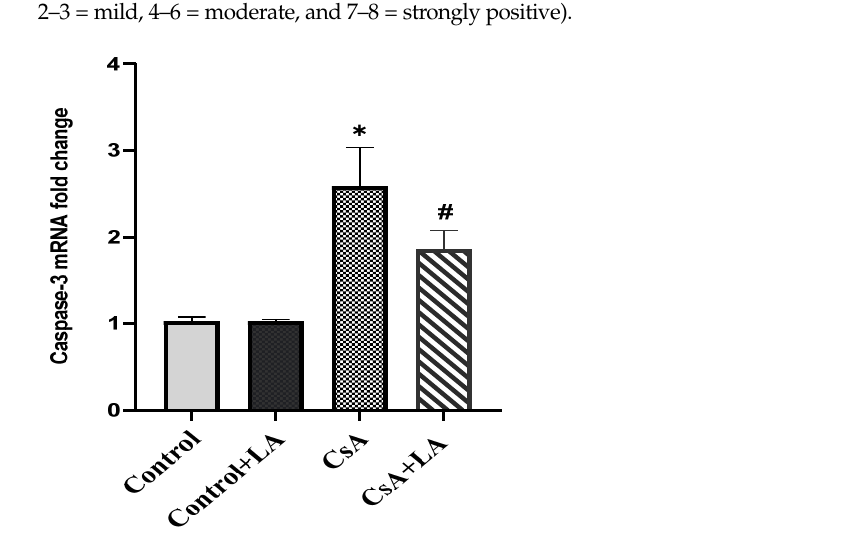
Figure 8. Microscopic pictures of immunostained hepatic sections against caspase-3. The control normal group ( A , B ) shows negative expression. Hepatic sections ( C , D ) from the CsA-treated group show prominent positive brown expression against caspase-3 (black arrows). Hepatic sections ( E , F ) from (CsA + LA) treated group show markedly decreased positive brown expression against caspase-3 in areas of perivascular necroinflammatory lesions (black arrows). IHC counterstained with Mayer’s hematoxylin, ( A , C , E ; Scale bar = 100 μ m), and ( B , D , F ; Scale bar = 50 μ m). ( G ) repre- sents the Allred score for caspase-3 cytoplasmic expression. Data are expressed as mean ± SE ( n = 8). *** p < 0.001 versus the control group, ## p < 0.01 versus the CsA group. Allred index (0–1 = nega- tive, 2–3 = mild, 4–6 = moderate, and 7–8 = strongly positive).